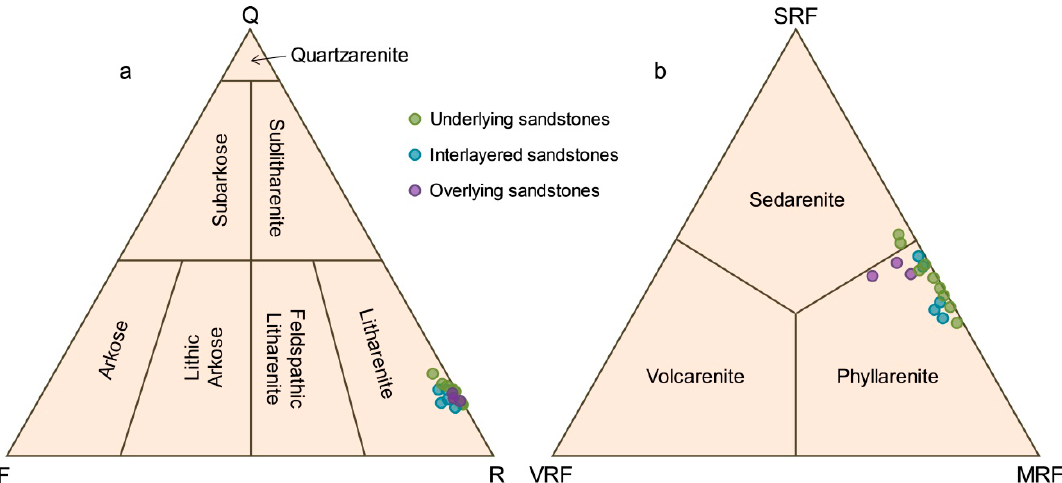
Figure 4. Ternary classification diagrams Q–F–R (Quartz–Feldspar–Rock fragments) ( a ) and SRF–VRF–MRF (Sediment rock fragments–Volcanic rock fragments–Metamorphic rock fragments) ( b ) after [41] for Sabantuy sandstones.